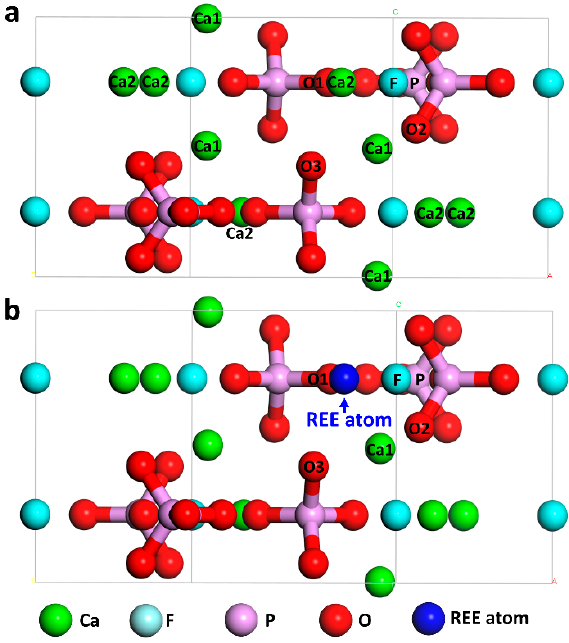
Figure 1. Models of perfect ( a ) and rare earth element (REE)-bearing fluorapatite crystals ( b